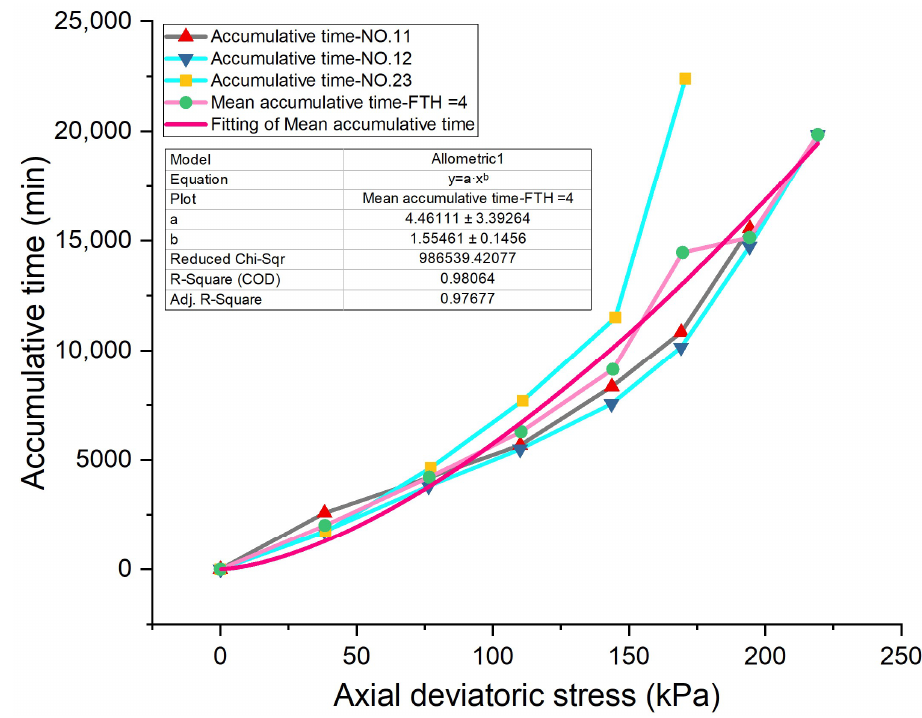
Figure 26. Accumulative time–axial deviatoric stress curves when FTH =